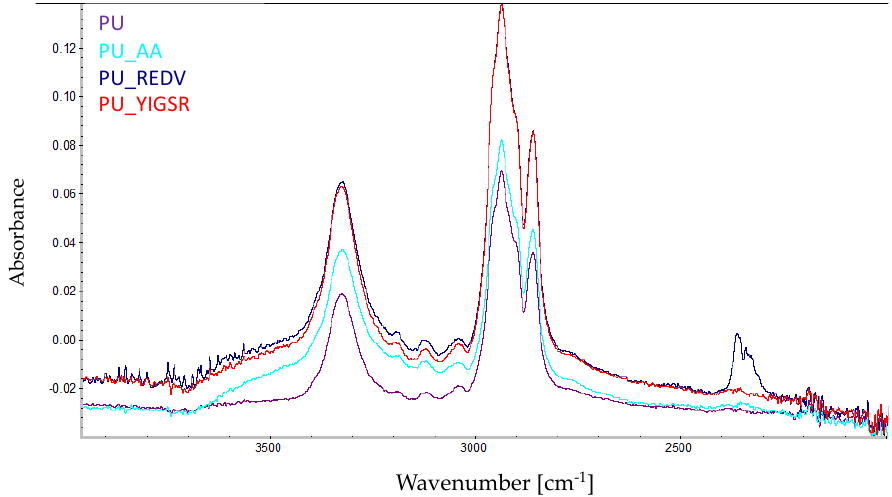
Figure 3. FTIR spectra recorded for the modified surfaces after each modification step.